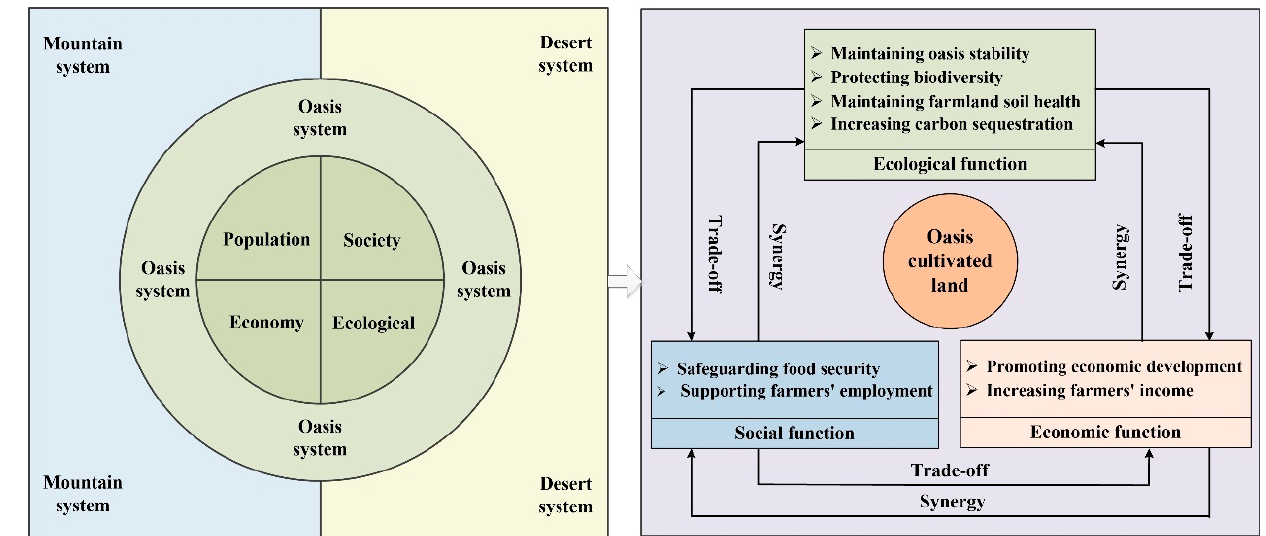
Figure 2. Functional connotation and classification of OCL in Xinjiang.